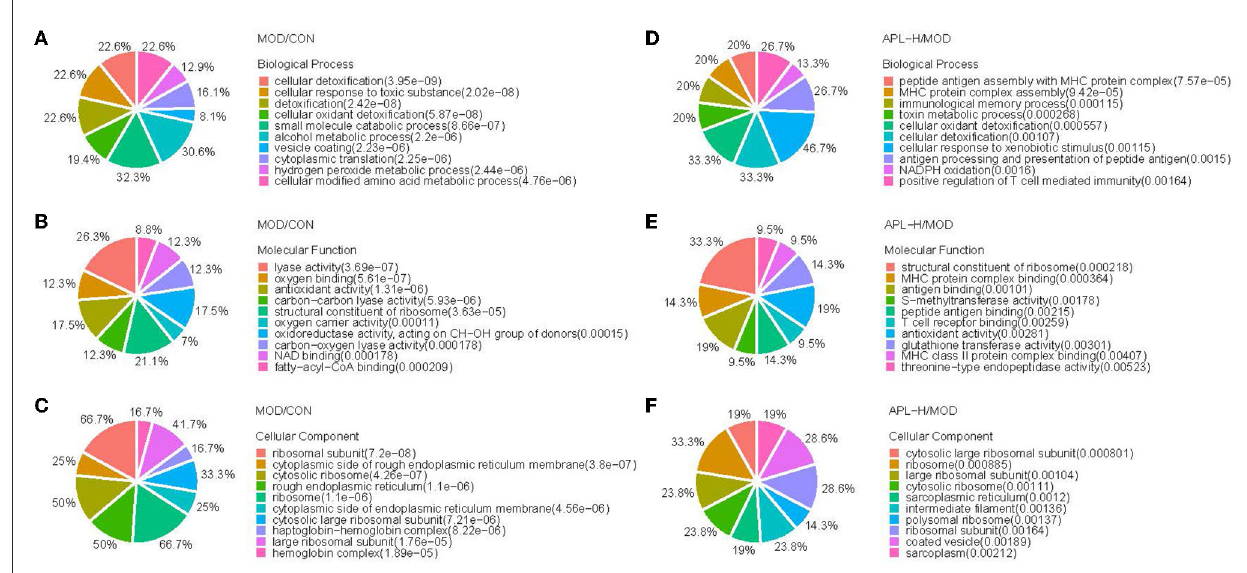
FIGURE7 GO analysis of the differentially expressed proteins. (A) Biological process analysis of MOD/CON; (B) Molecular function analysis of MOD/CON; (C) Cellular component analysis of MOD/CON; (D) Biological process analysis of APL-H/MOD; (E) Molecular function analysis of APL-H/MOD; (F) Cellular component analysis of